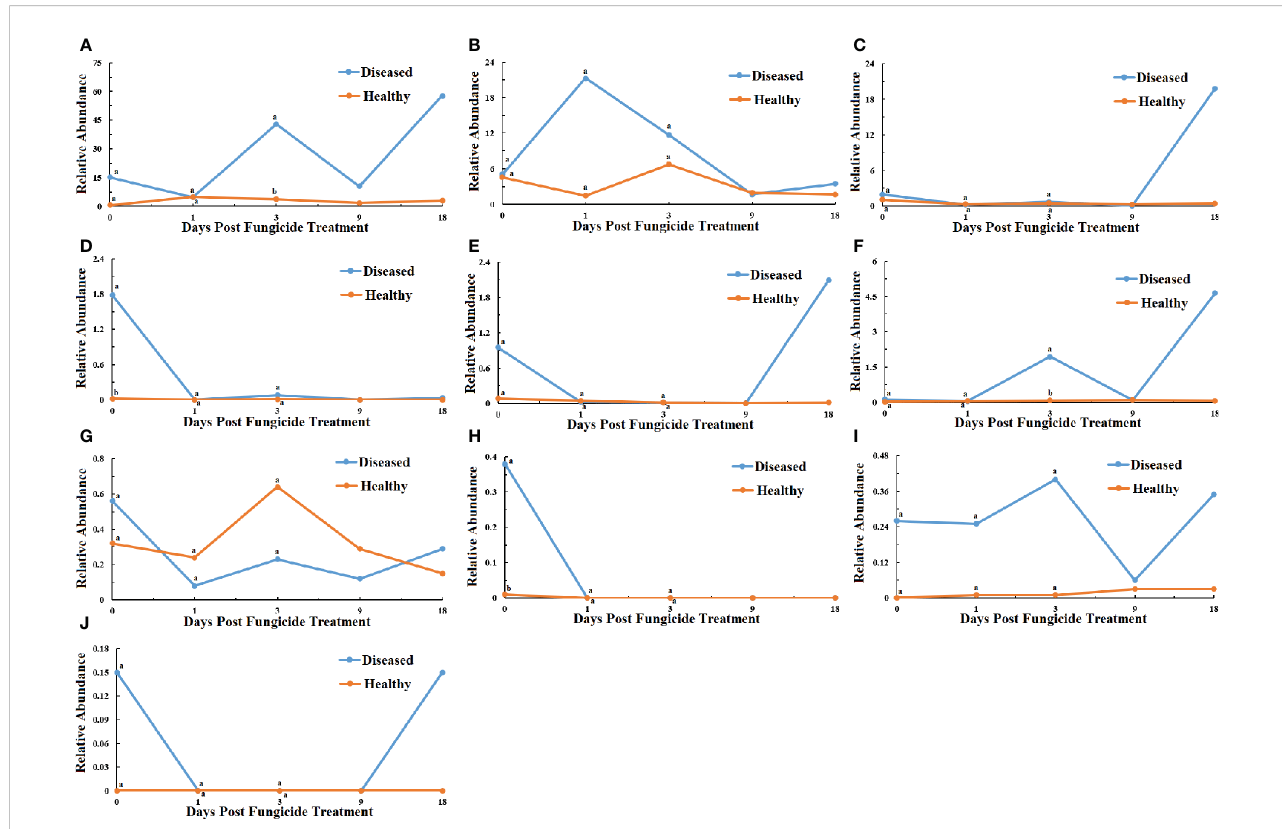
FIGURE 4 Changes in bacterial community compositions at the genus level for diseased and healthy leaves over time after azooxystrobin treatment. (A) Pseudomonas , (B) Methylobacterium , (C) Sphingomonas , (D) unidenti fi ed_Rhizobiaceae , (E) Massilia , (F) Pantoea , (G) Aureimonas ,